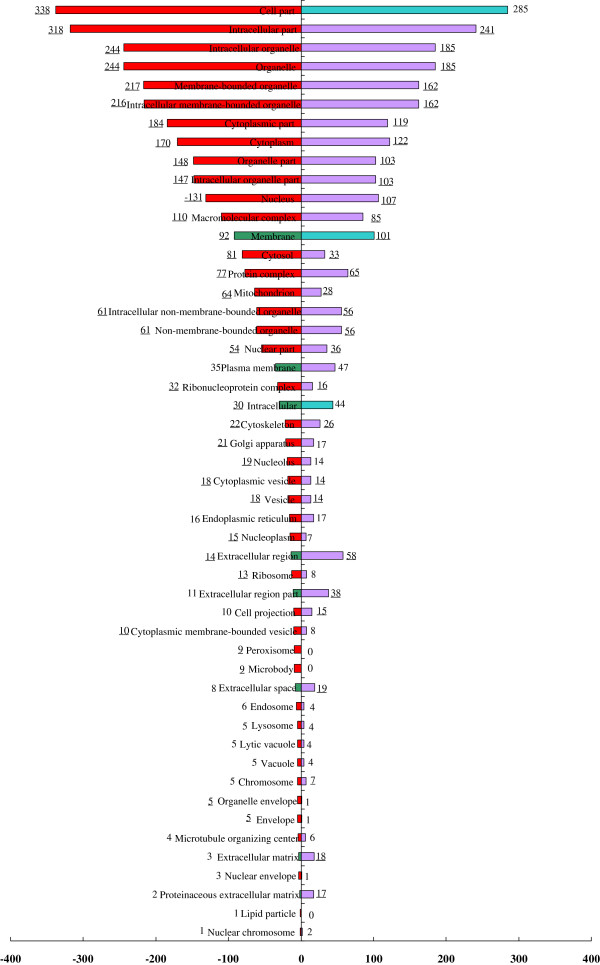
Enriched/depleted GO celluar component terms for the set of cancer/normal cells specific proteins. Purple/red indicates enriched terms in normal/cancer stromal cells; light blue/dark green indicates depleted terms in normal/cancer stromal cells. Underline indicates significantly enriched/depleted terms.